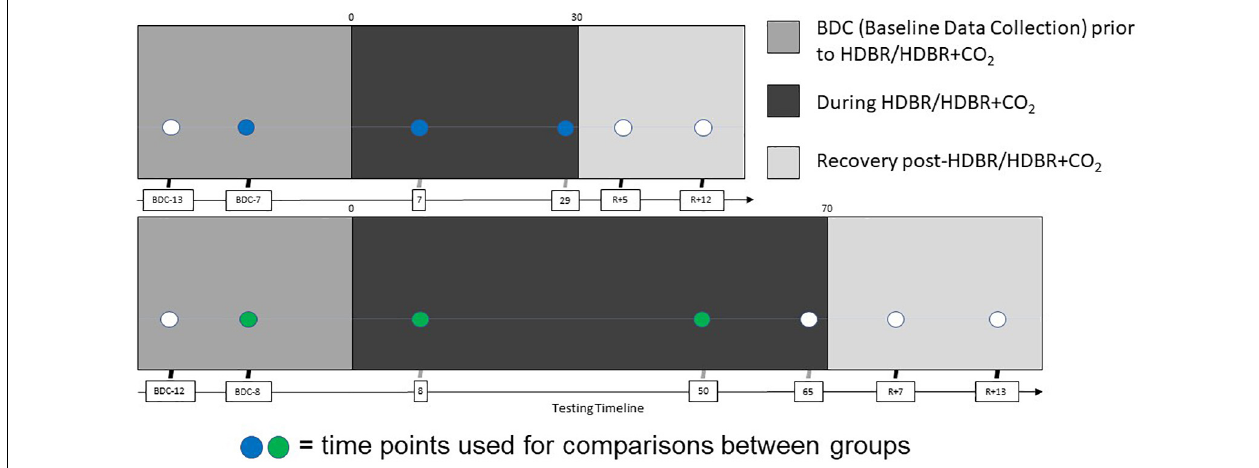
FIGURE 1 | Testing timeline. (Top) Testing timeline for HDBR + CO 2 intervention. Two initial acquisitions sessions took place 13 and 7 days prior to bedrest (BDC-13 and BDC-7), two more were made on the 7th and 29th days of the HDBR + CO 2 intervention, and the final two were made 5 and 12 days after the end of bedrest (R+5 and R+12). (Bottom) Testing timeline for HDBR intervention. HDBR acquisition occurred at seven sessions: 14.1 ± 3.8 days and 7.9 ± 2.0 days before the start of HDBR, 8.4 ± 1.0 days, 50.6 ± 0.9 days, and 66.8 ± 1.8 days after the onset of HDBR, as well as 6.7 ± 0.8 days and 11.4 ± 1.6 days after HDBR (Yuan et al., 2016). Each time point for both interventions included cognitive-motor dual task behavioral testing with concurrent fMRI acquisition. The sessions used for intercept, slope, and normalized slope comparisons between groups are indicated in blue (HDBR + CO 2 ) and green